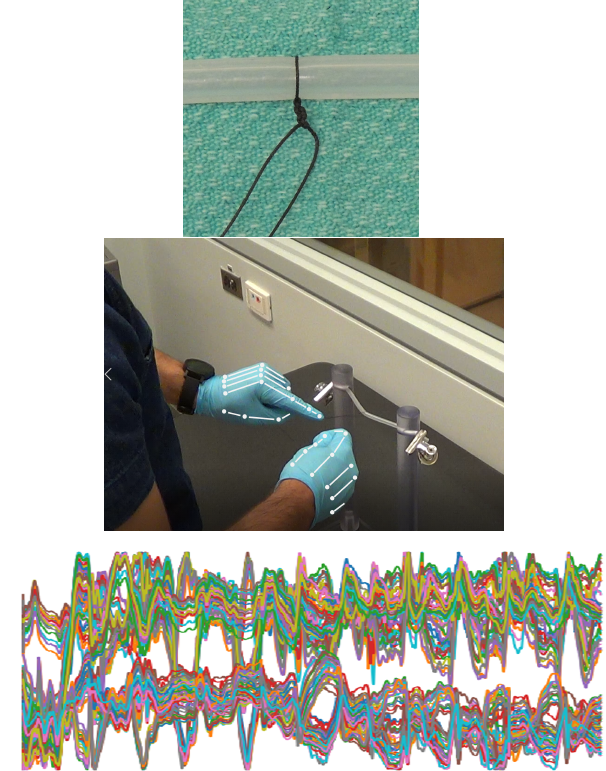
Figure 1. The trials were recorded using three modalities. The top is an image of the final product, the middle is a screen capture of the video data with a visualization of the joints tracked by the Leap sensor. The bottom is an example of the kinematic time series data, representing the temporal 3-dimensional movement of the hand joints during the knot tying